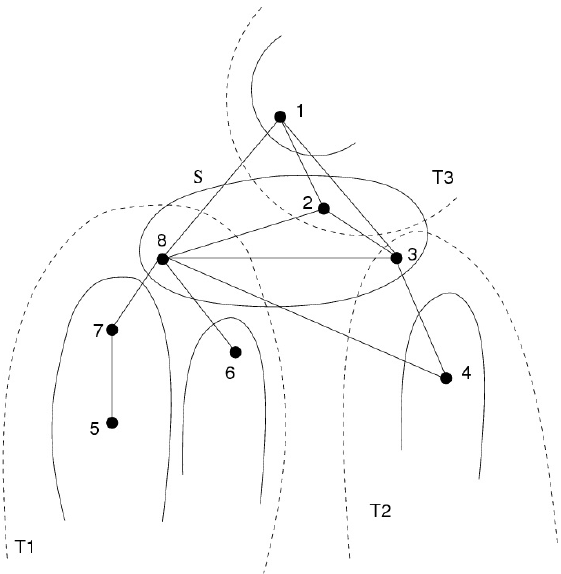
Figure 4 . The slices defined by an execution of MCS on a chordal graph. The substars of 1 are { 8 } and { 3 , 8 }